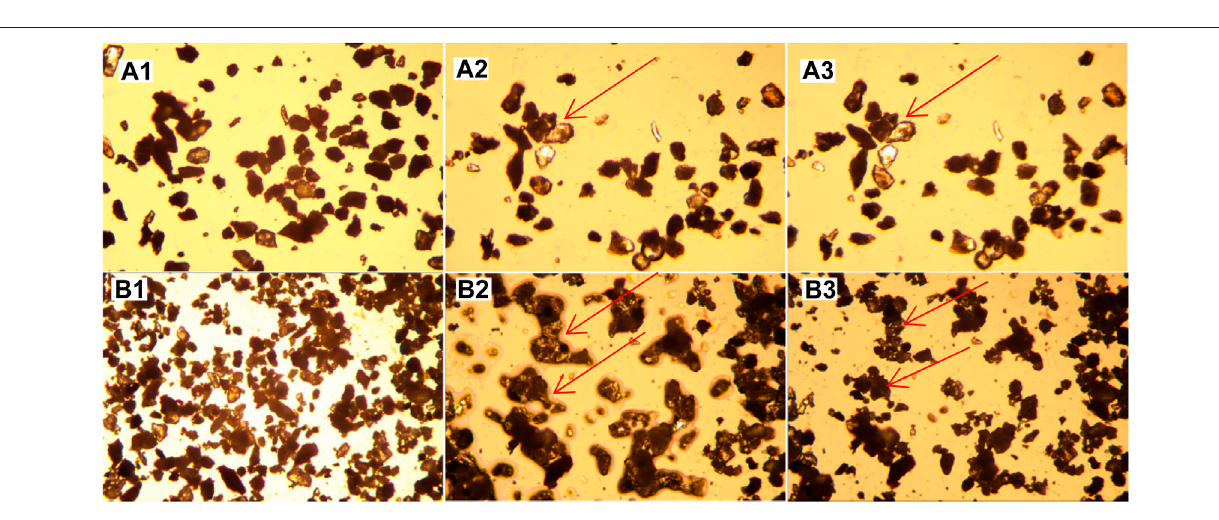
Frontiers in Environmental Science |